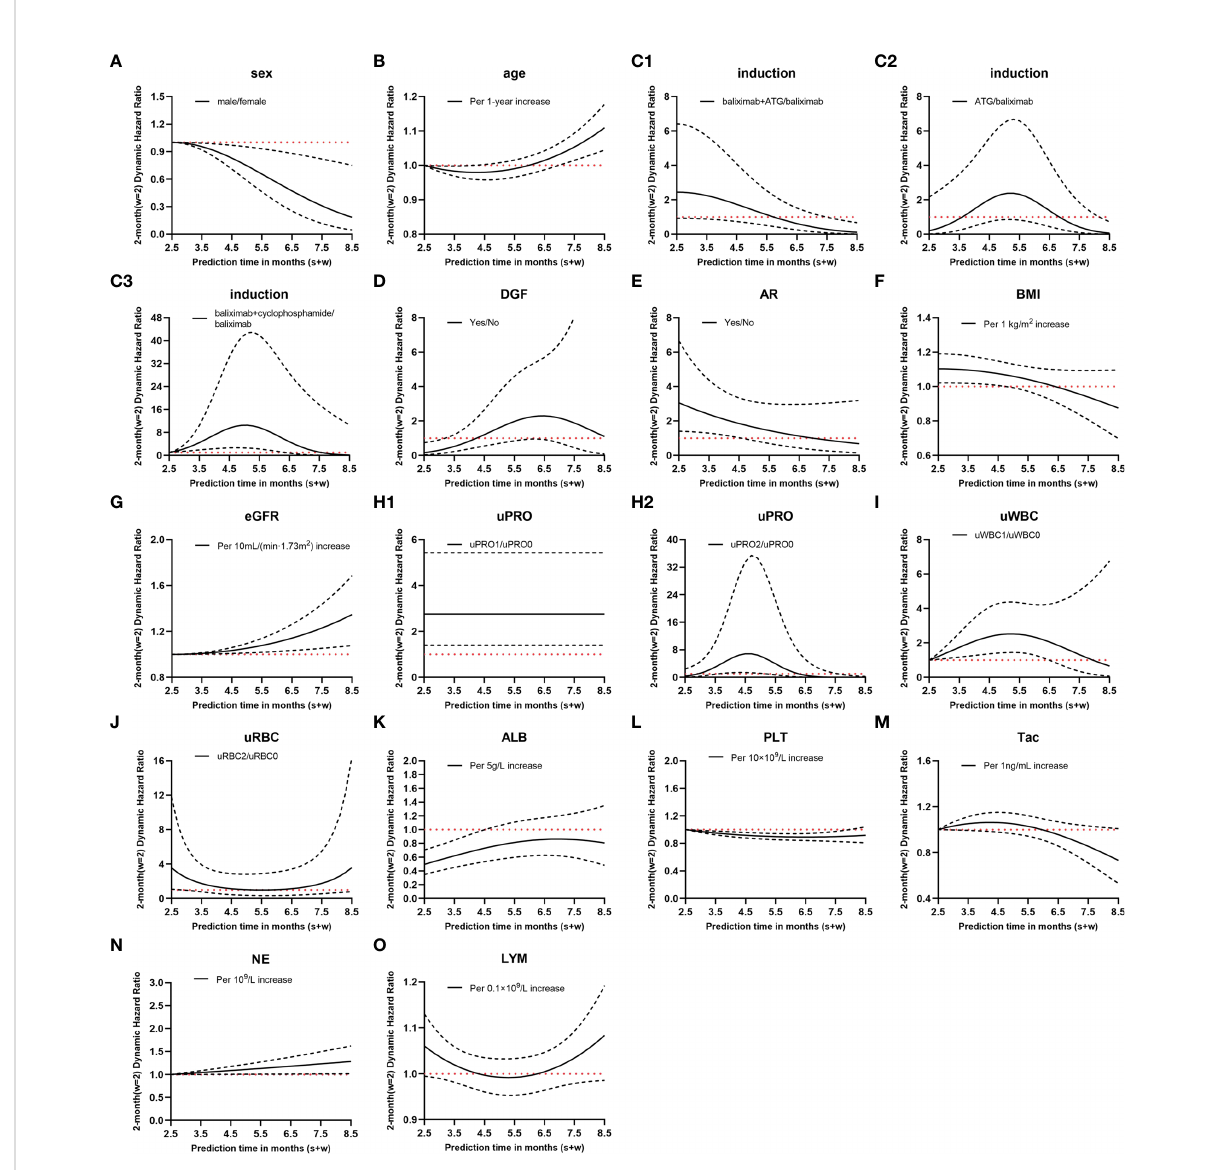
FIGURE 3 Hazard ratio (HR) values of dynamic Cox regression. (A – O) , different variates; C1 – 3, different immune induction schemes; H1 – 2, different levels of urinary protein; solid lines, dynamic HR of different variates; dashed lines, 95% con fi dence intervals; red dotted lines, HR=1; induction, immune induction scheme; ATG, antithymocyte globulin; DGF, delayed graft function; AR, acute rejection; BMI, body mass index; eGFR, estimated glomerular fi ltration rate; uPRO, urinary protein; uPRO0, negative result of urinary protein; uPRO1, low level of urinary protein; uPRO2, high level of urinary protein; uWBC, urinary leukocyte; uWBC0, negative result of urinary leukocyte; uWBC1, low level of urinary leukocyte; uRBC, urinary erythrocyte; uRBC0, negative result of urinary erythrocyte; uRBC2, high level of urinary erythrocyte; ALB, serum albumin; PLT, platelet count; Tac, blood tacrolimus concentration; NE, blood neutrophil count; LYM, blood lymphocyte